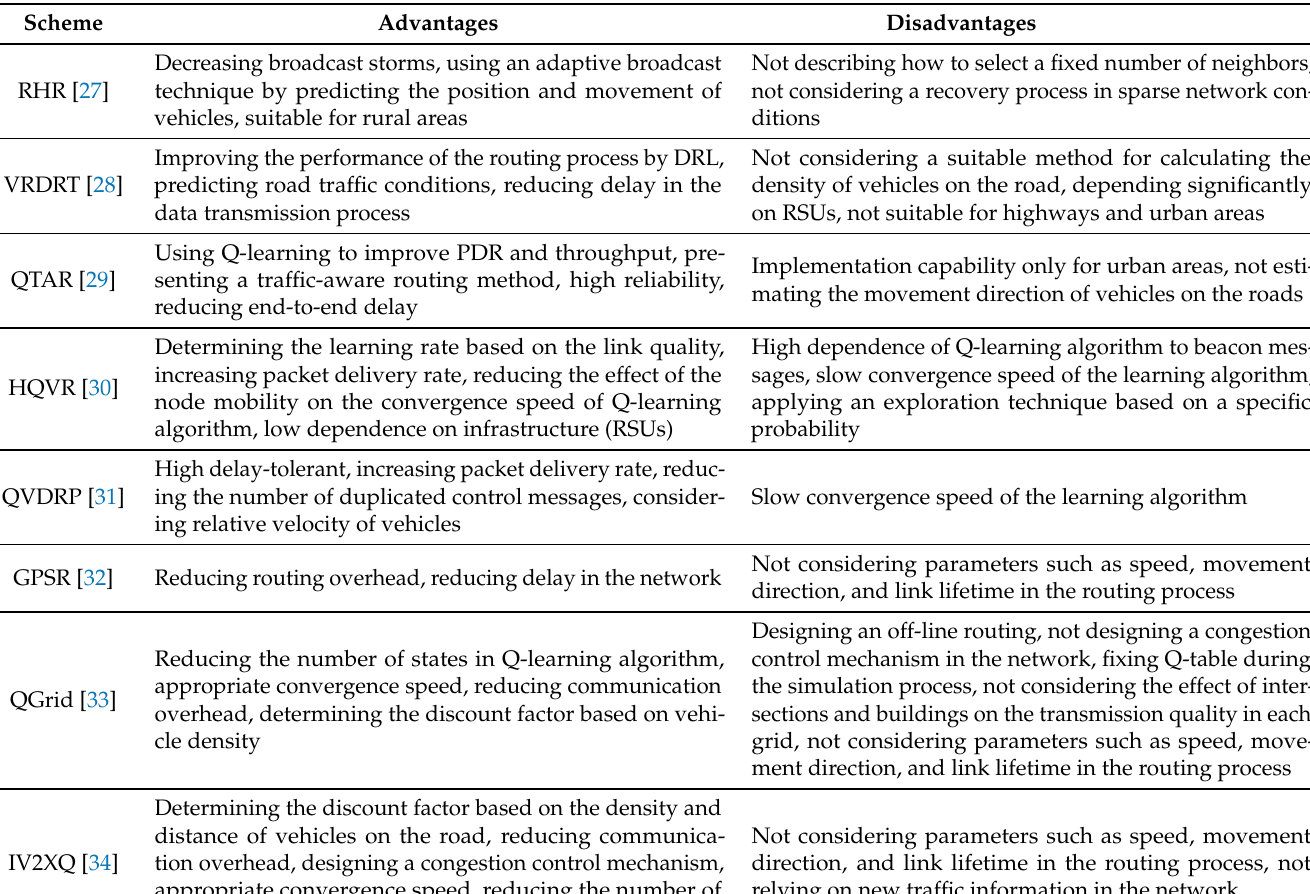
Table 1. The advantages and disadvantages of the related